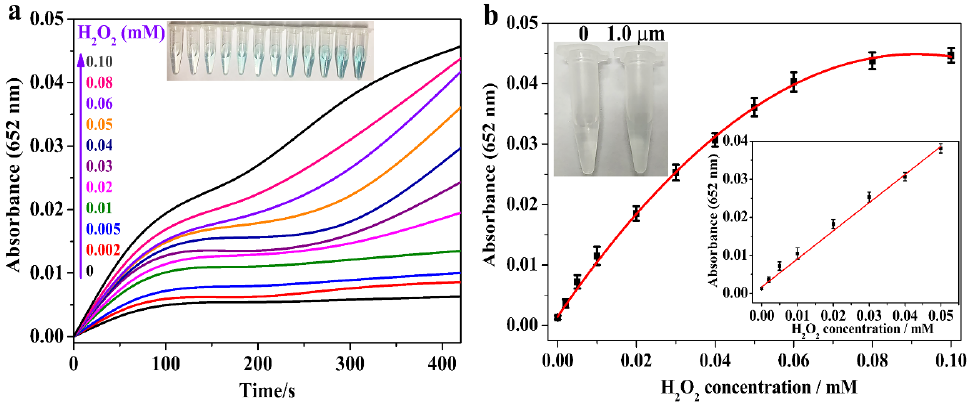
Figure 6. Time-dependent absorbance changes at 652 nm in the presence of different concentrations of H 2 O 2 in 25.0 mM PBS (pH = 4.0) with 120 µ g/mL MoS 2 @CNNS(30) and 0.8 mM TMB at room temperature ( a ) and a dose-response curve for H 2 O 2 detection ( b ). Inset: related color changes and the linear calibration plot of H 2 O 2 .